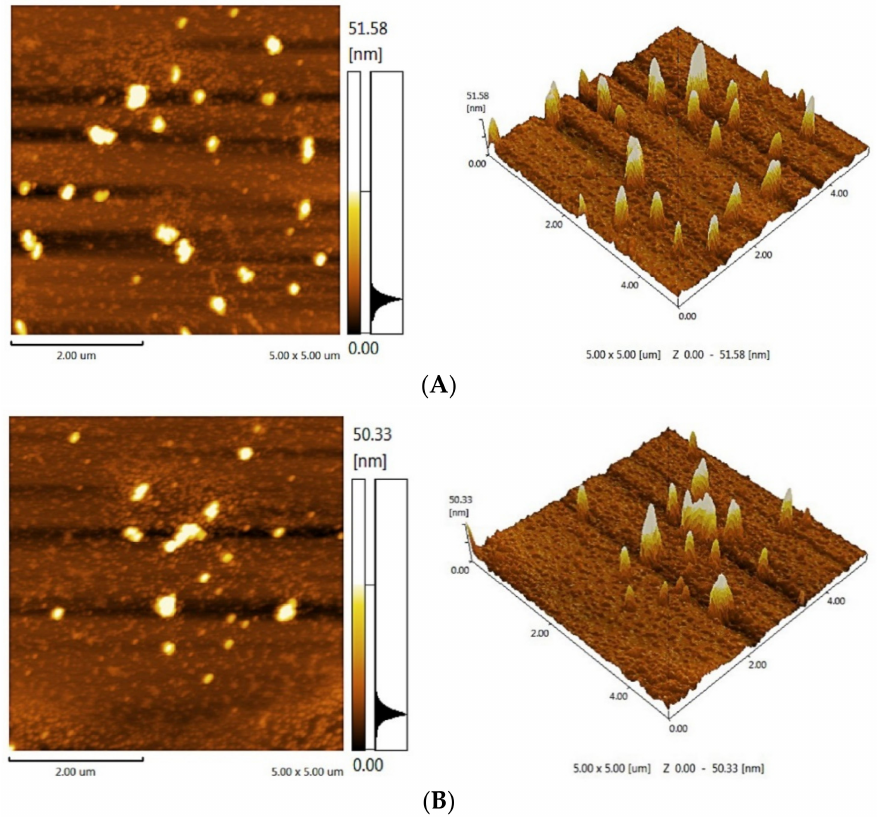
Figure 5. AFM diagram of PFSI-1 ( A ) and PFSI-2 ( B